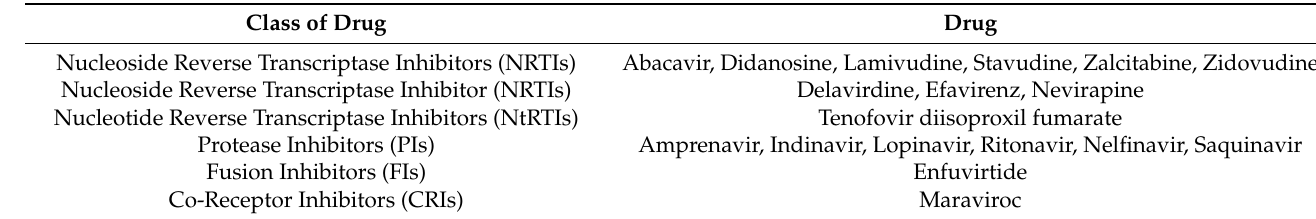
Table 1. Available CDC-approved ART drugs used in HAART therapy. Class of Drug